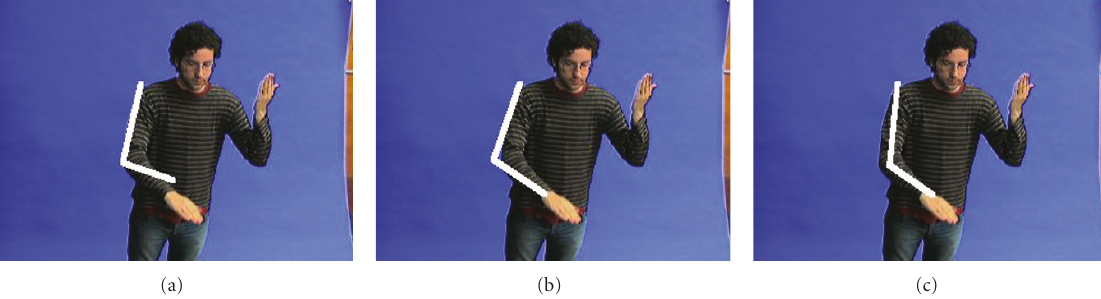
Figure 3: (a) Initial configuration of the articulated chain, (b) IK estimation, (c) result by adding the image constraint.